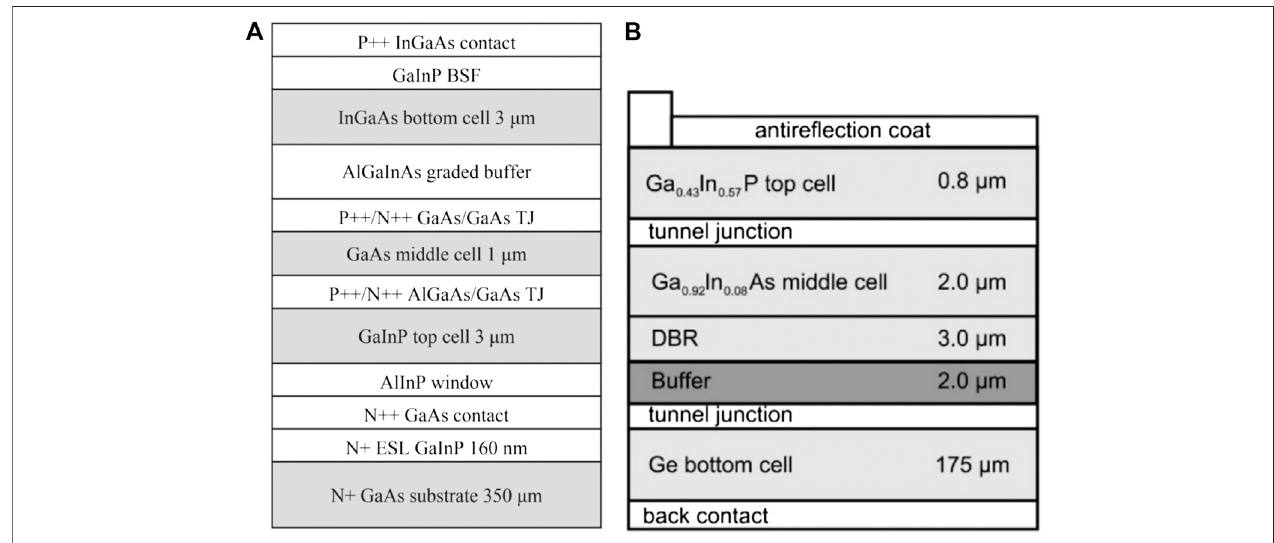
FIGURE 3 | Schematic structure of (A) GaInP/GaAs/InGaAs IMM solar cell, and (B) GaInP/InGaAs/Ge UMM solar cell [78].